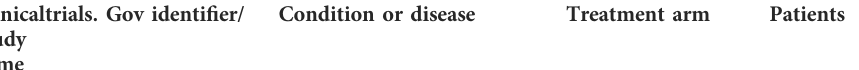
TABLE 2 Phase II clinical trials of PARPis plus other drugs in OC/TNBC with published